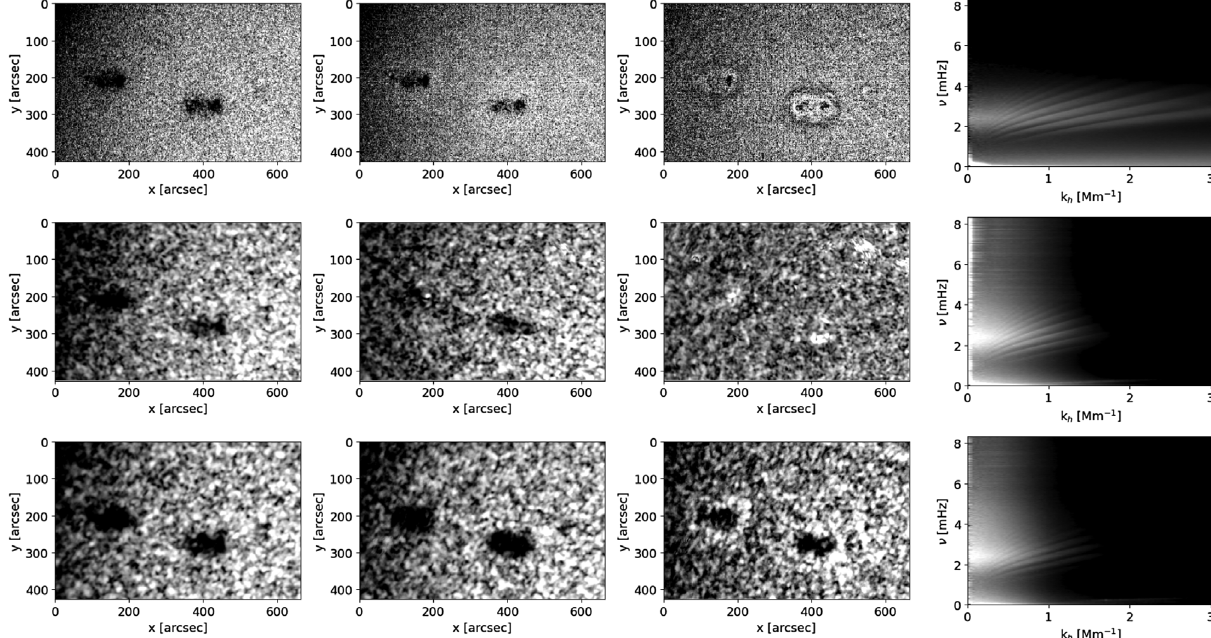
Fig. 12. Power maps of the region of interest and diagnostic diagram. Each row corresponds to HMI ( top ), potassium MOTH channel ( center ) and sodium MOTH channel ( bottom ), the column on the right shows the power spectra of the region, whereas the other columns correspond to power maps at 4 mHz ( left ), 5 mHz ( center ) and 7 mHz ( right